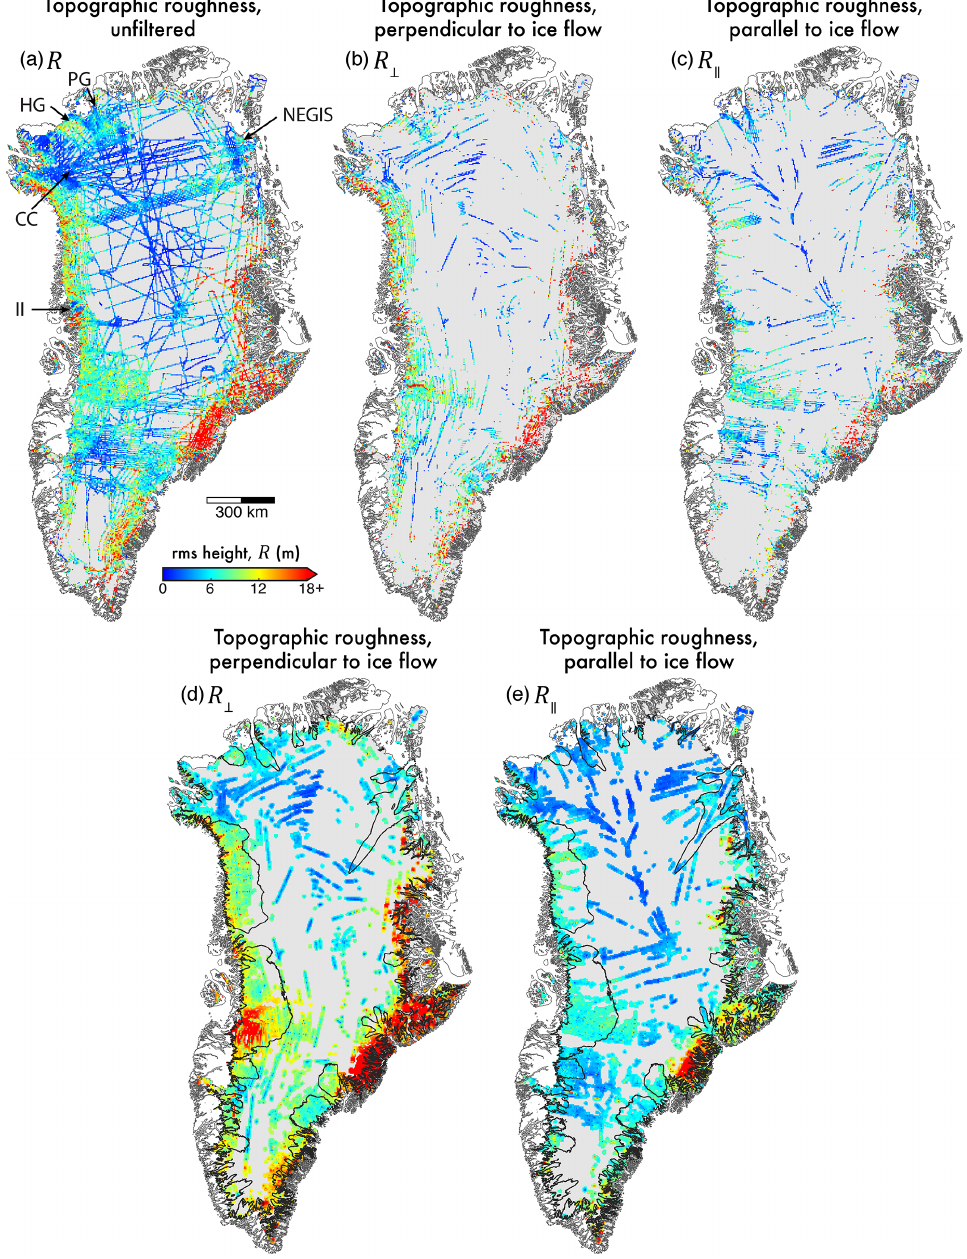
Figure 5. Topographic roughness ( R ) across the GrIS. (a) R unfiltered by flow direction. (b) R ⊥ . (c) R (cid:107) . (d) and (e) show spatial interpolation of (b) and (c) to a width of 20km, respectively, for improved visualisation. Locations for Ìngia Isbræ (II), NEGIS, Petermann Glacier (PG), Humboldt Glacier (HG), and Camp Century (CC) drilling site, as referred to in the text, are